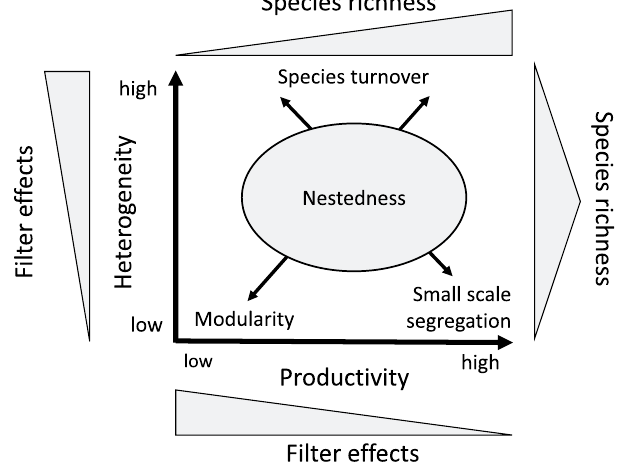
Figure 1. The interplay of environmental heterogeneity and productivity influences the spatial geometry of species occurrences and of species richness. High productivity and low heterogeneity increase the importance of interspecific competition leading to a small-scale segregated pattern of species co-occurrences. Low heterogeneity and productivity cause species to concentrate on islands of fertility leading to an aggregated (modular) pattern of occurrence. A high degree of heterogeneity favours species turnover irrespective of the degree of productivity, while intermediate degrees of both variables should be associated with a nested pattern. Therefore, nestedness is expected to occur particularly in species rich meta-communities at intermediate degrees of habitat